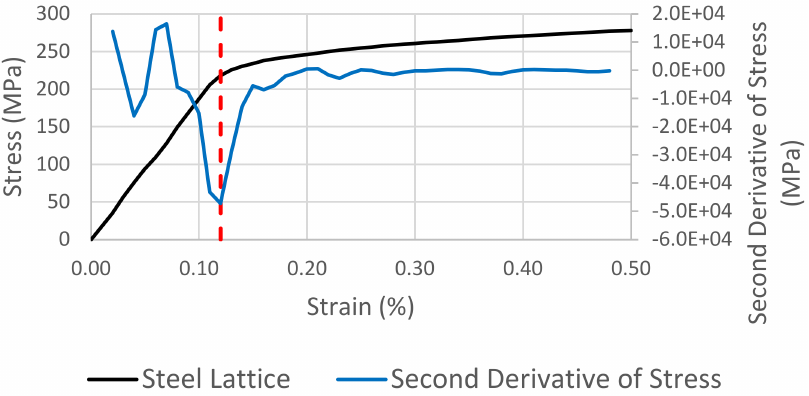
Figure 9. Derivative yield as applied to the experimentally measured stress–strain curve for a steel lattice subjected to tensile loading. The Strain axis to 0.5 enables the best illustration.